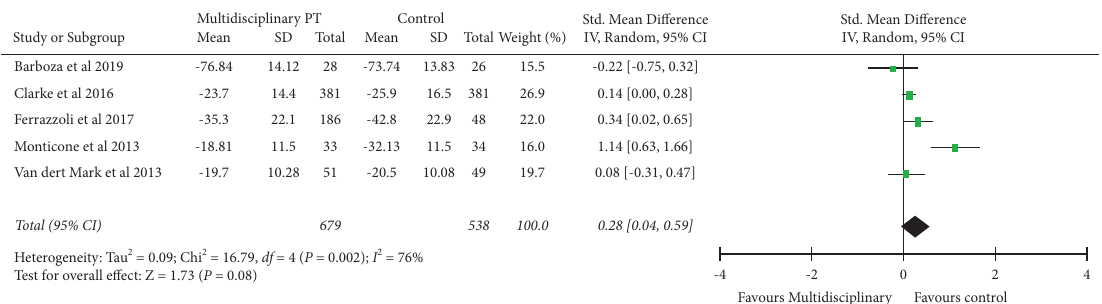
Heterogeneity: Tau 2 = 0.61; Chi 2 = 27.95, df = 3 ( P < 0.00001); I 2 = 89% Test for overall effect: Z = 1.58 ( P = 0.11) Figure 3: Forest plot multidisciplinary physiotherapy with the control group: disability status.